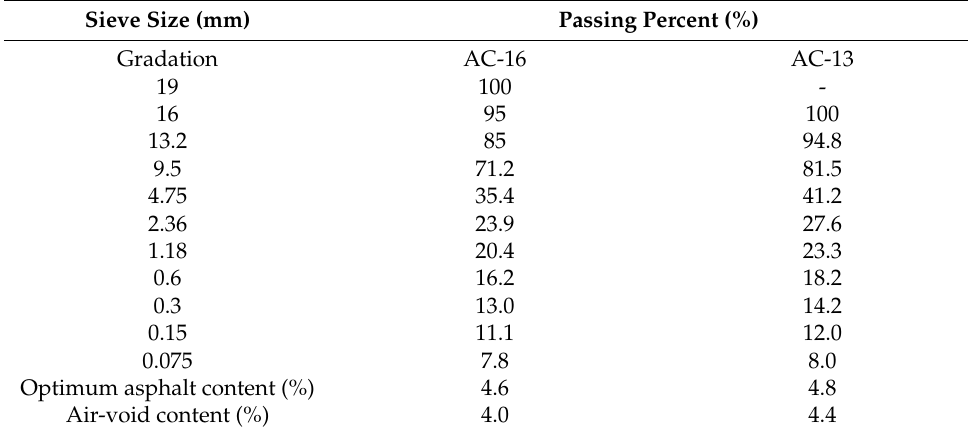
Table 2. Aggregate gradations and mix design results of AC